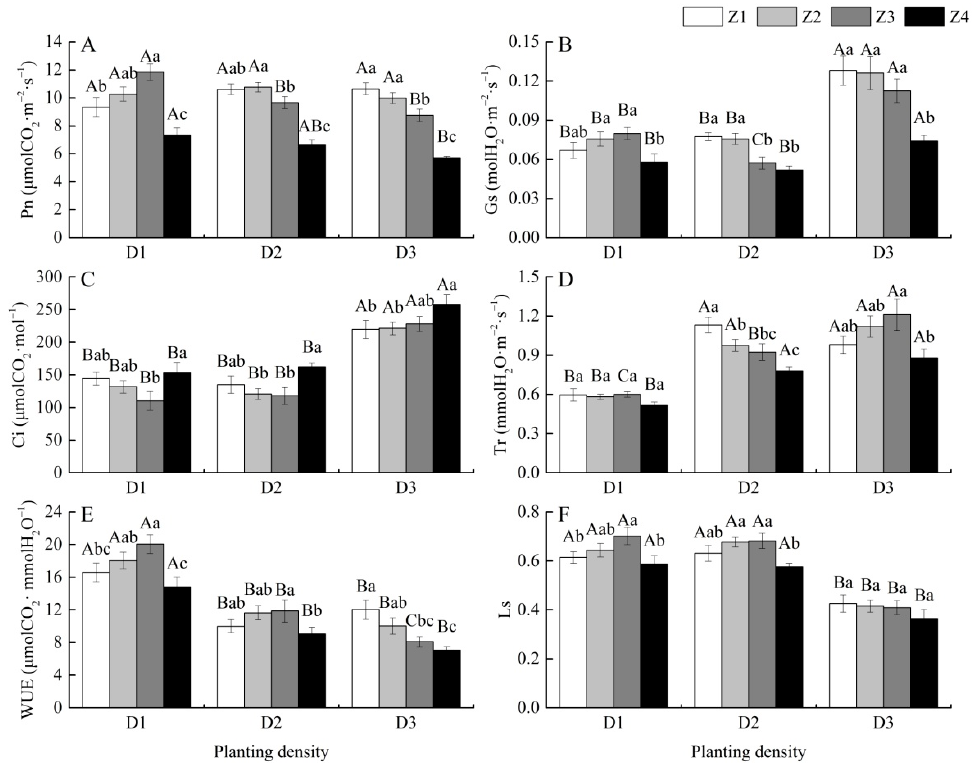
Figure 2. Net photosynthetic rate (Pn, A ), stomatal conductance (Gs, B ), intercellular CO 2 concentration (Ci, C ), transpiration rate (Tr, D ), water use efficiency (WUE, E ), and limiting value of stomata (Ls, F ) of C. lanceolata saplings in different leaf positions (Z1–Z4) and under different planting densities (D1–D3; as detailed in the caption of Figure 1).